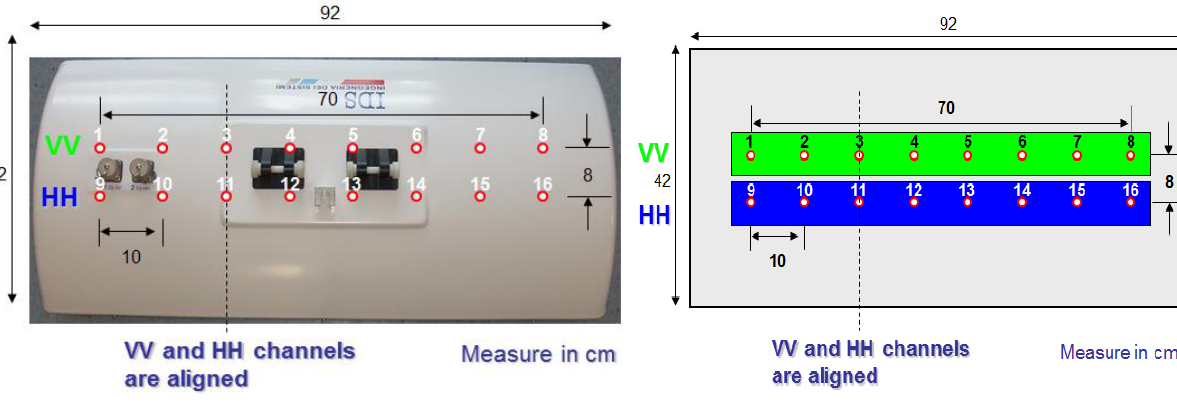
Figure 8. The IDS Hi BriT (2 GHz) antenna array: layout [37].